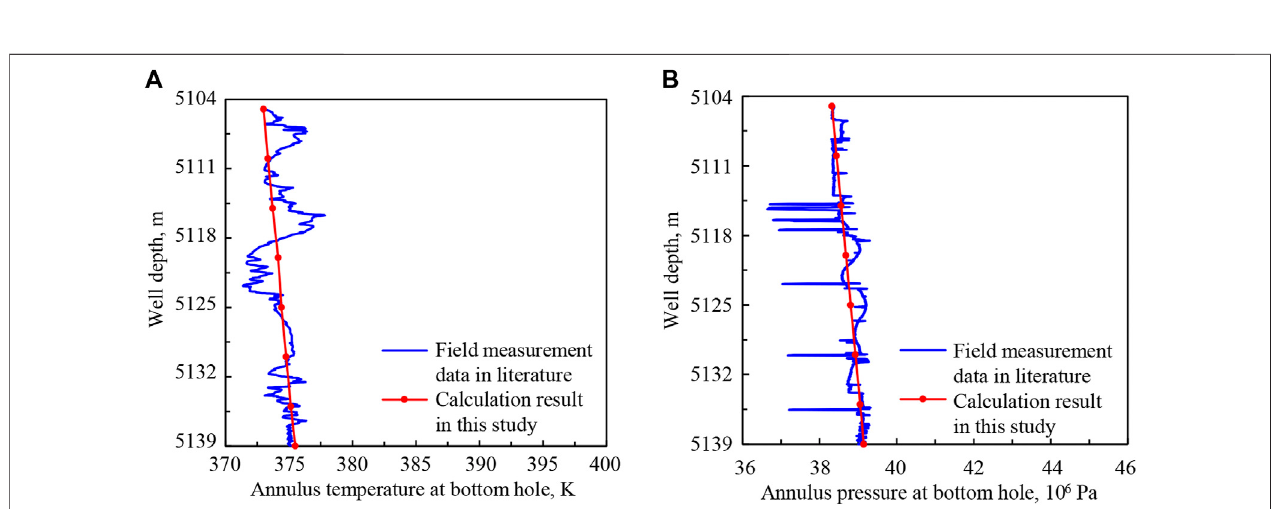
FIGURE5| Thecomparisonsbetweennumericalresultsand fi eldmeasurementdataofNP-X: (A) annulustemperatureatthebottomhole; (B) annuluspressureat the bottom hole.